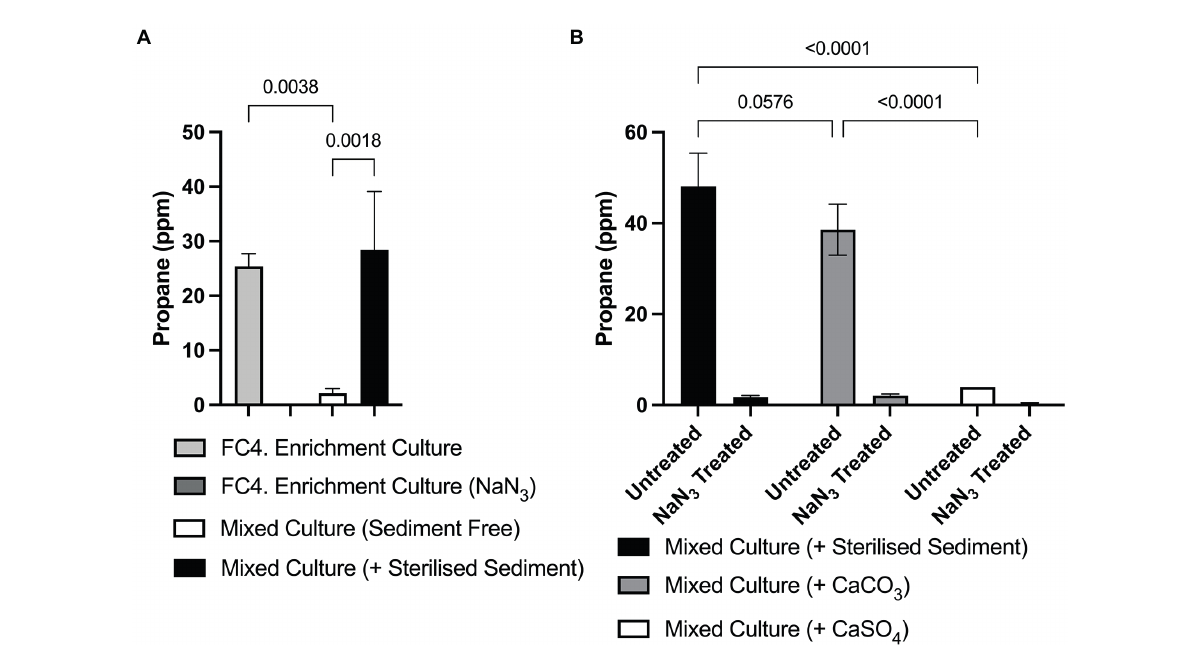
FIGURE 5 Propane production in marine sediment enrichment cultures requires either supplementation with sterilized marine sediment or CaCO 3 . (A) Significantly higher amounts of propane were detected both in initial cultures containing marine sediment, and in enrichment cultures supplemented with sterile marine sediment compared to an enrichment culture where sediment had been removed and not replaced by supplementation of the growth medium. (B) Significantly higher amounts of propane were detected in enrichment cultures supplemented with either sterile sediment or CaCO 3 compared to either the NaN 3 treated negative control samples or enrichment cultures supplemented with CaSO 4 . One-way ANOVA with Dunnett’s post hoc test ( p ≤ 0.05, n =